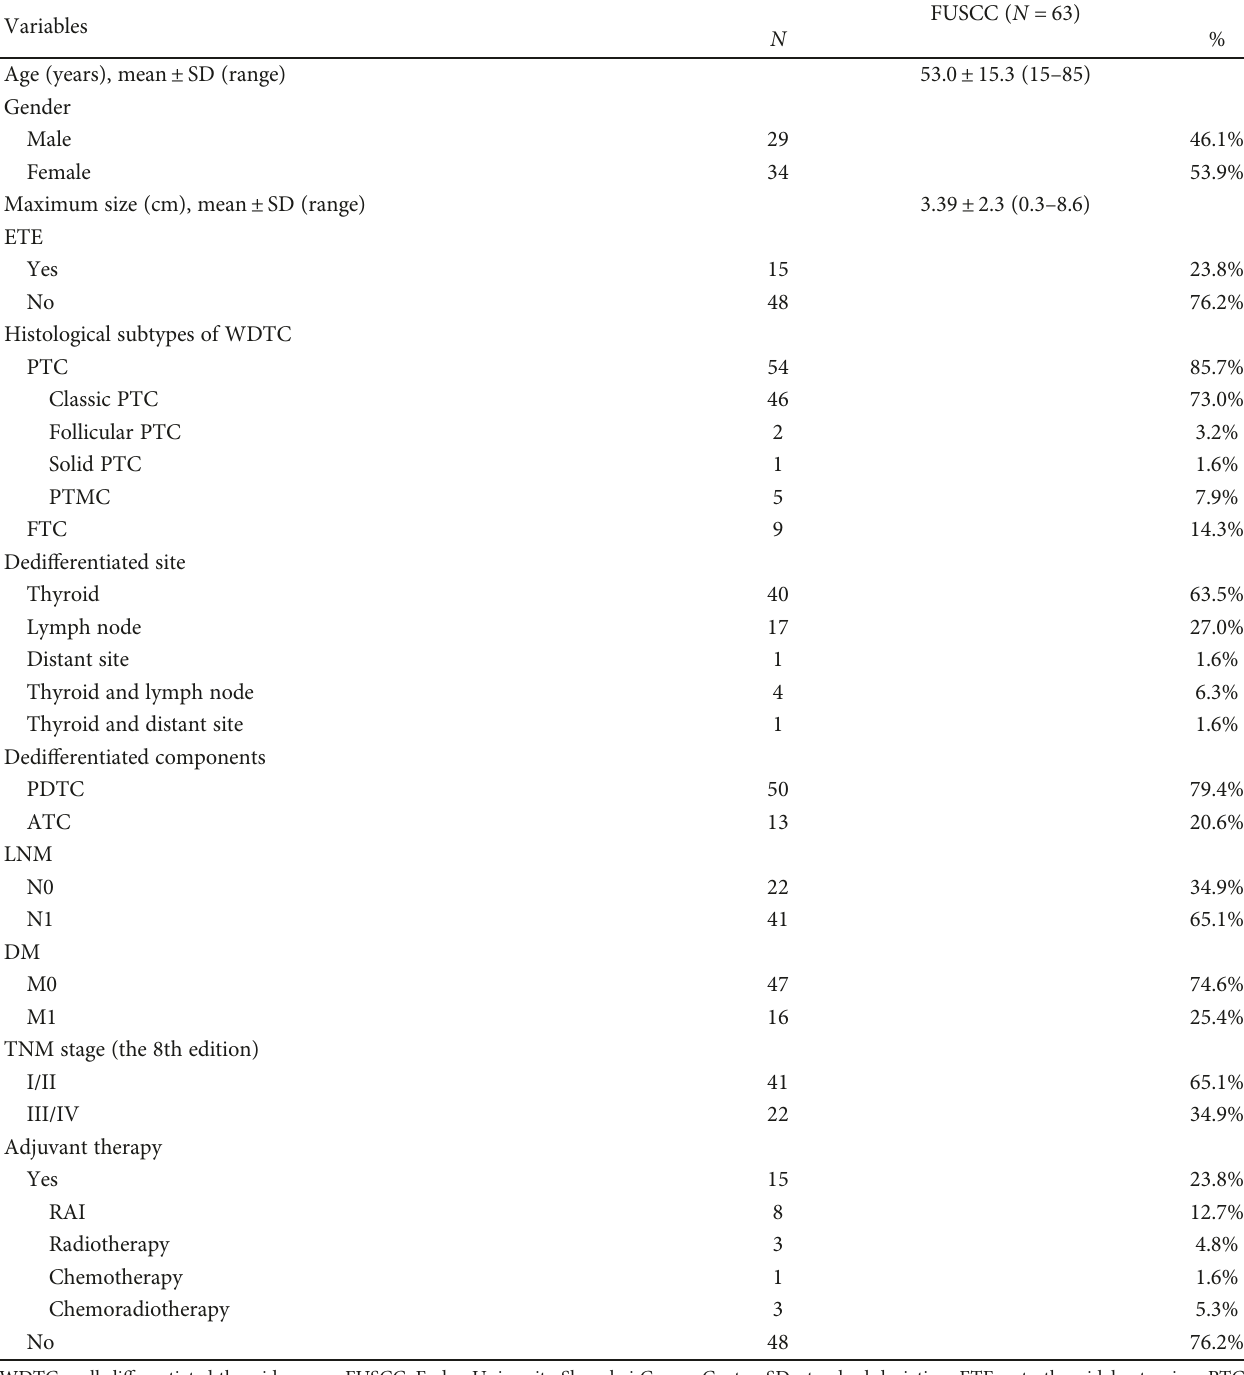
Table 1: Summary of WDTC patients harboring dedi ff erentiated phenotype in the FUSCC cohort.